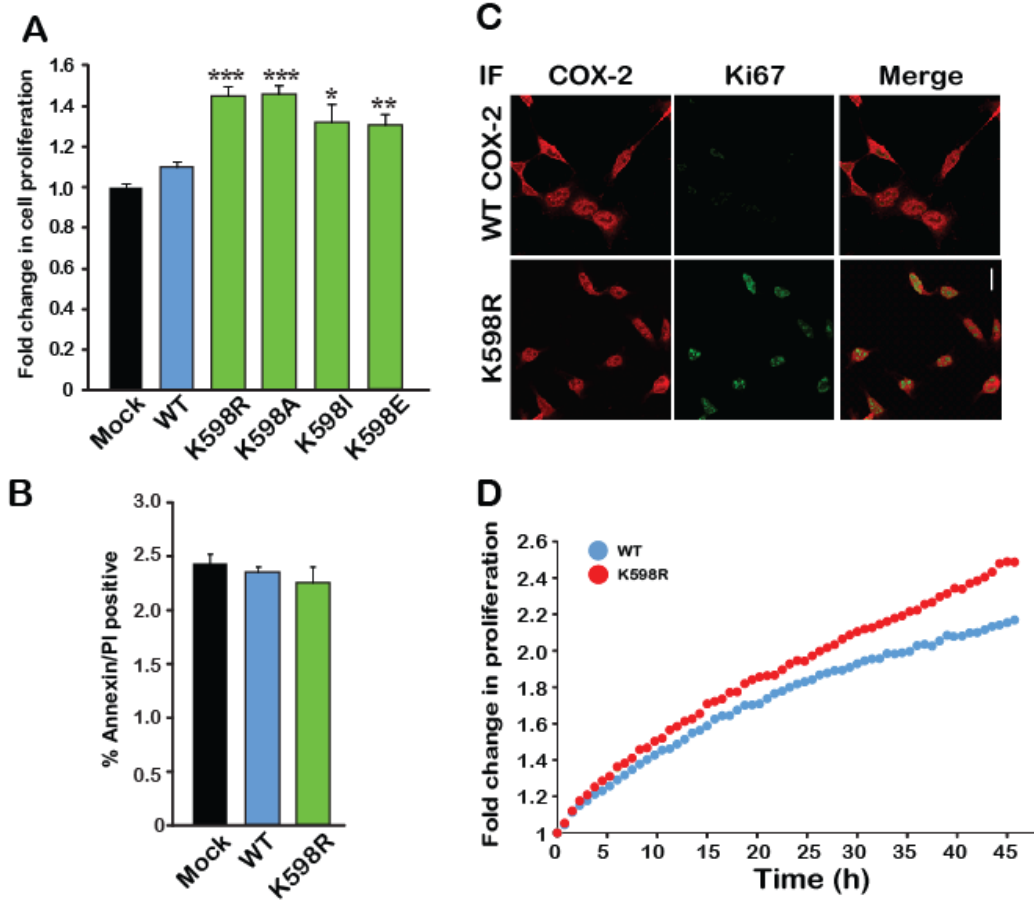
Figure 3. A mutation in K598 COX-2 enhances cell proliferation. ( A ) The effect of WT COX-2 and the different K598 COX-2 mutants on cell proliferation was assessed by the XTT proliferation assay, 36